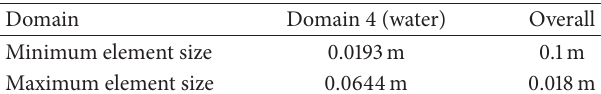
Table 5: Mesh details.